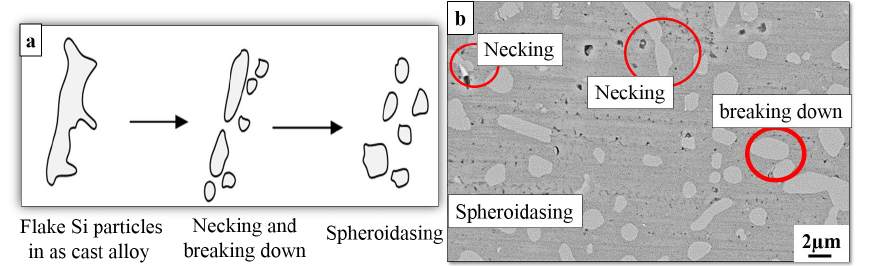
Table 1. Average size of Si particles.